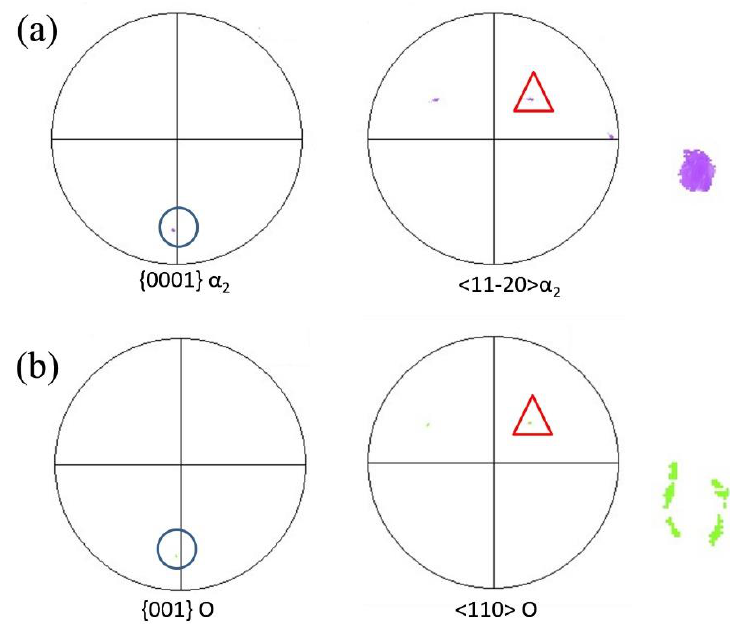
Figure 10. ( a ) {110} and <111> pole figures of the B2 phase, ( b ) {001} and <110> pole figures of the red lamellar O phase.